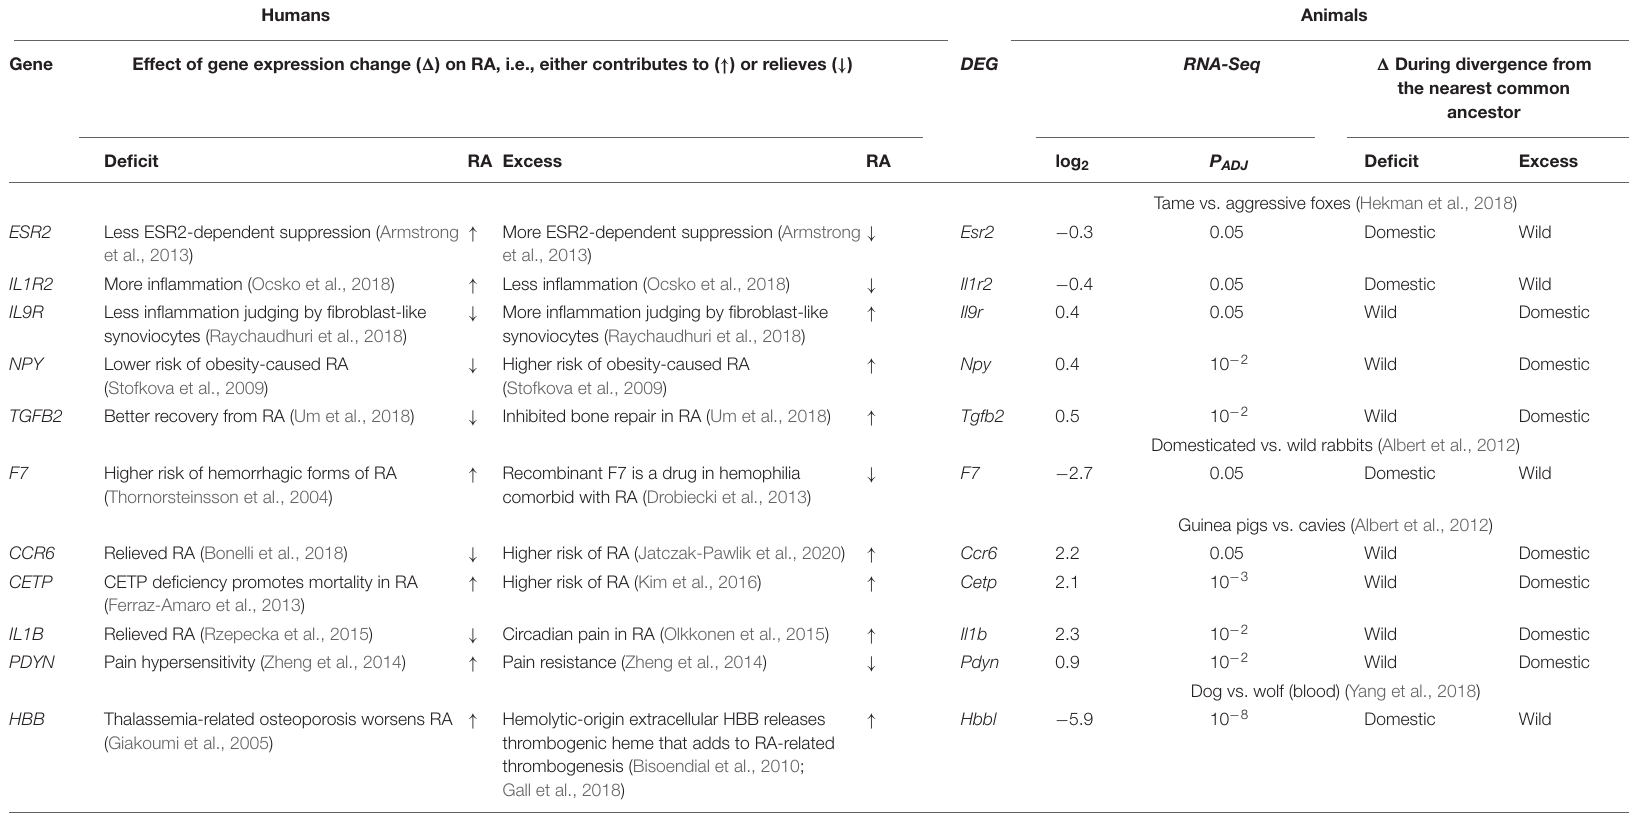
log 2 : differential expression of a gene of pets normalized to that in wild animals (log 2